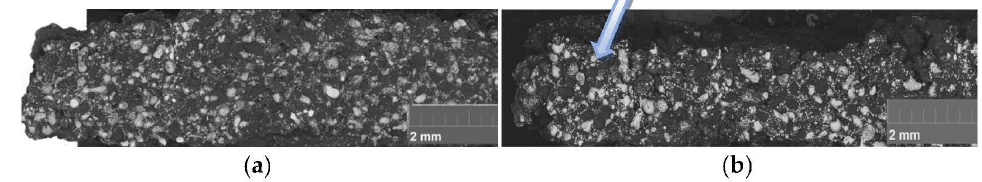
Figure 15. Microphotographs of the cross-sectional split before ( a ) and after ( b ) deformation.